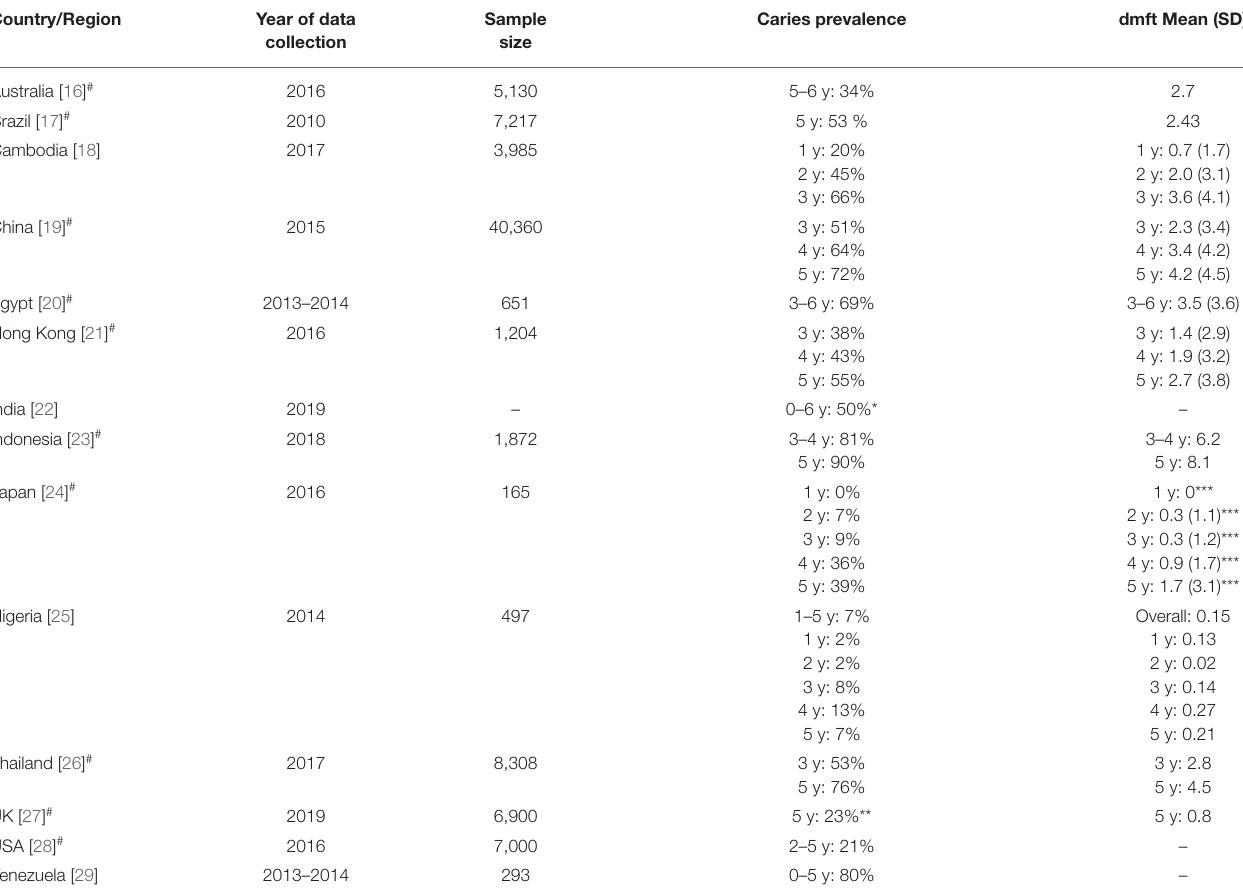
TABLE 1 | Early childhood caries: prevalence and caries experience in different countries/regions included in this review.